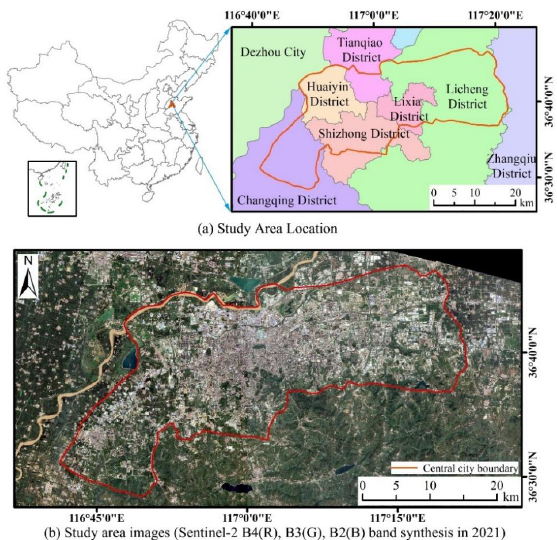
Figure 1. Study area overview. (a) Study Area Location; (b) Study area images (Sentinel-2 B4 (R), B3 (G), B2 (B) band synthesis in 2021).